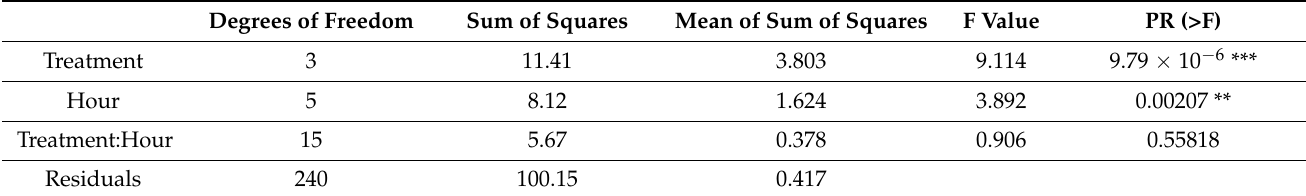
Table A9. Interaction